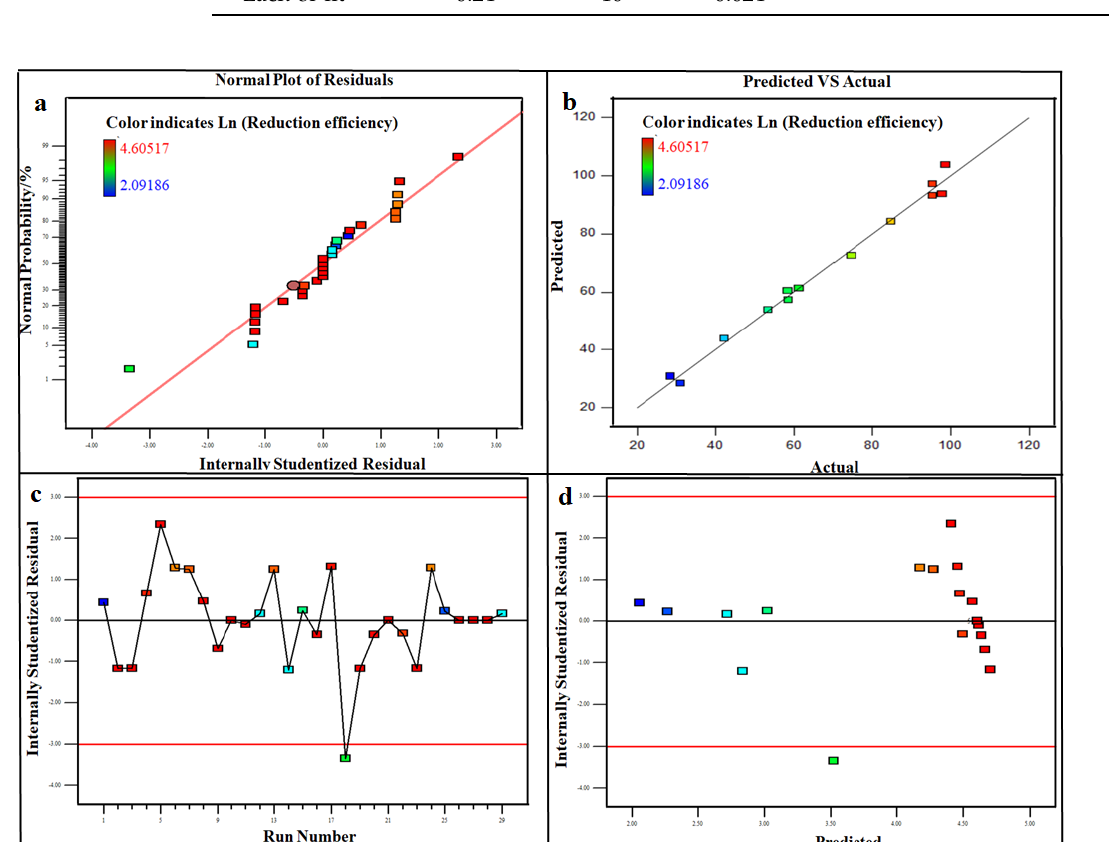
Figure 5. Diagnostic plots of the quadratic model. ( a ) Internally studentized residual, ( b ) actual, ( c ) run number, ( d ) predicted.